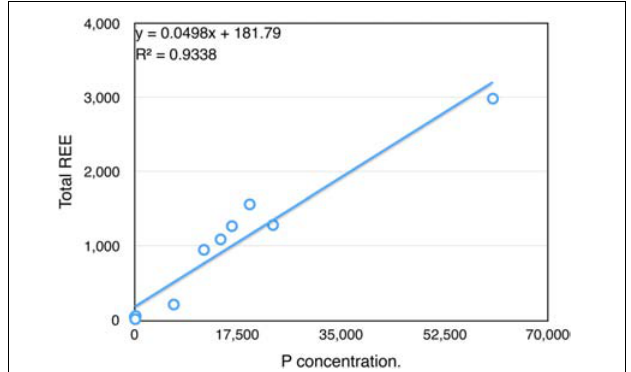
FIGURE 4 | Excellent Correlation between P (phosphorus) and (cid:54) La_REE in Lufengosaurus skeletal elements. P and (cid:54) La_REE values inside the bones of the Early Jurassic Lufengosaurus measured at different ontogenetic stages show strong correlation (0.9338) regardless of the stage of growth. Complete data can be found in Supplementary Table S3